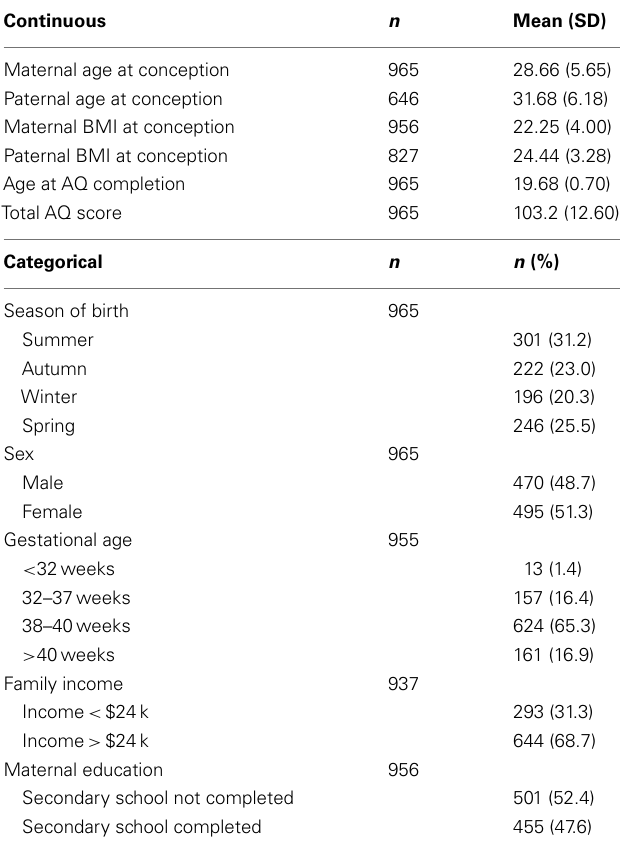
Table 1 | Characteristics of Raine study participants withAQ and GWA data available.